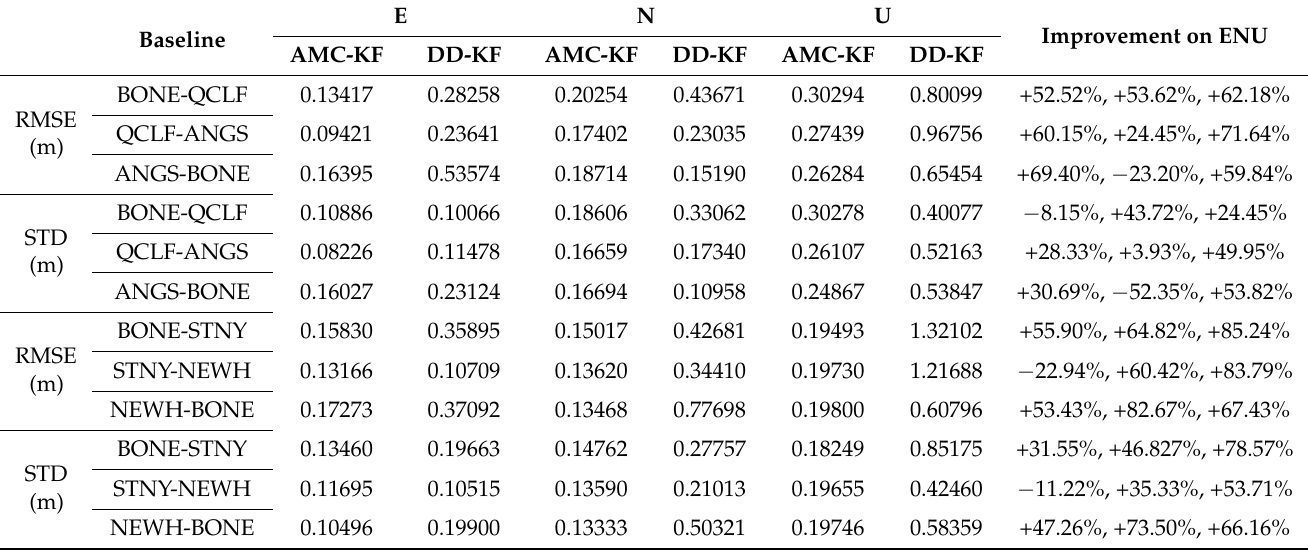
Table 2. RMS and STD improvement on ENU for